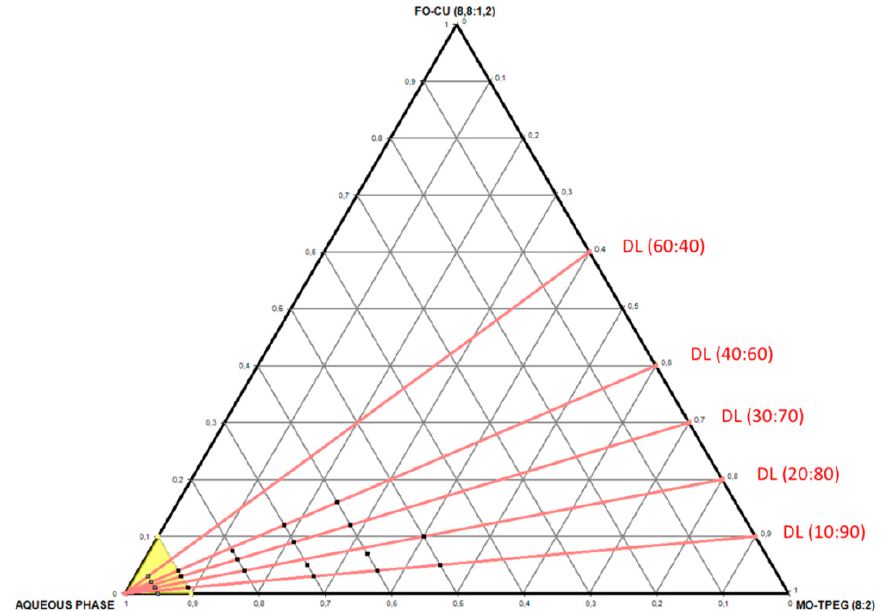
Figure 2. Phase diagram showing the dilution lines for the preparation of nanocarriers composed of monoolein (MO), TPEG 1000 amphiphile, fish oil (FO), curcumin (CU), and water. The MO / TPEG 1000 and FO / MO weight ratios are constant (80:20 and 88:12, respectively). The water-rich region is represented by a yellow triangle. The aqueous phase contains catalase (CAT) in the CAT-loaded formulations. The black points indicate the compositions for which experimental biological synchrotron small-angle X-ray scattering (BioSAXS) data are shown in Section 2.1.3 in the sequence from more concentrated to more diluted assemblies: samples C195, C196, C197 and C199 on the dilution line DL 10:90; samples C285, C286, C287 and C288 on the dilution line DL 20:80; samples C376, C377, C378 and C379 on the dilution line DL 30:70; and samples C466, C467, C468 and C469 on the dilution line DL 40:60.